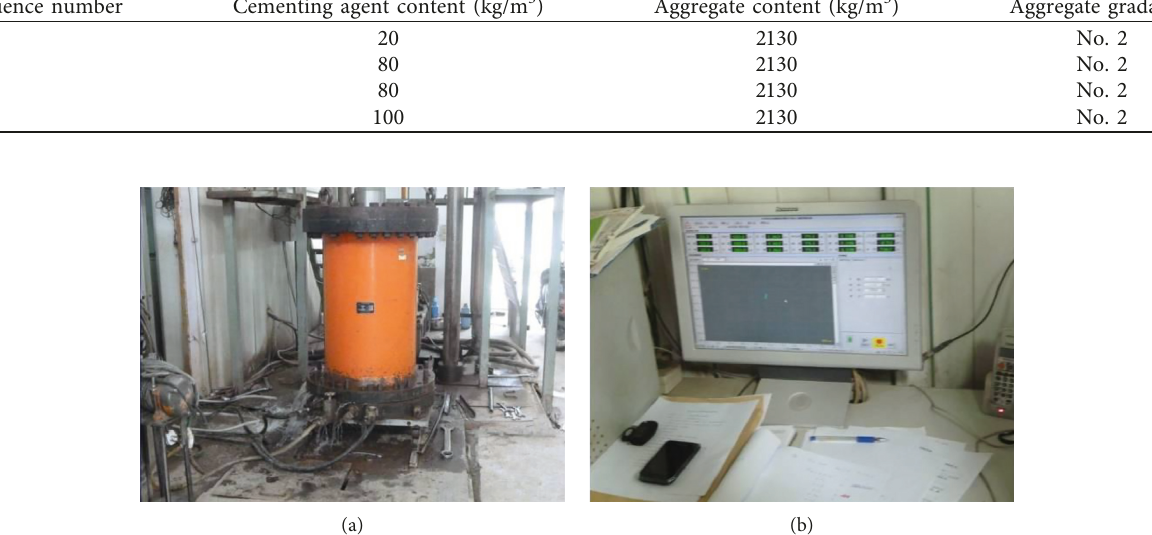
Table 3: Test programs of Material II to investigate effects of cementing agent content and aggregate gradation. Sequence number